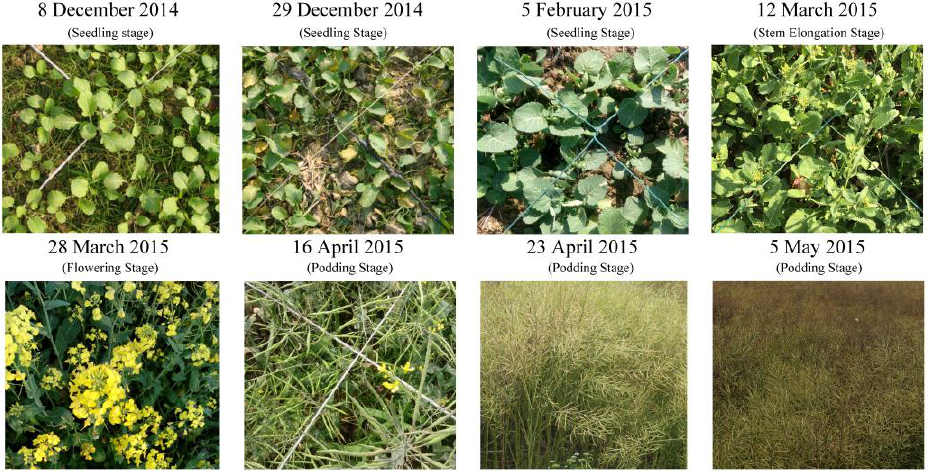
Figure 6. Winter oilseed rape seasonal growth from 2014 to 2015.